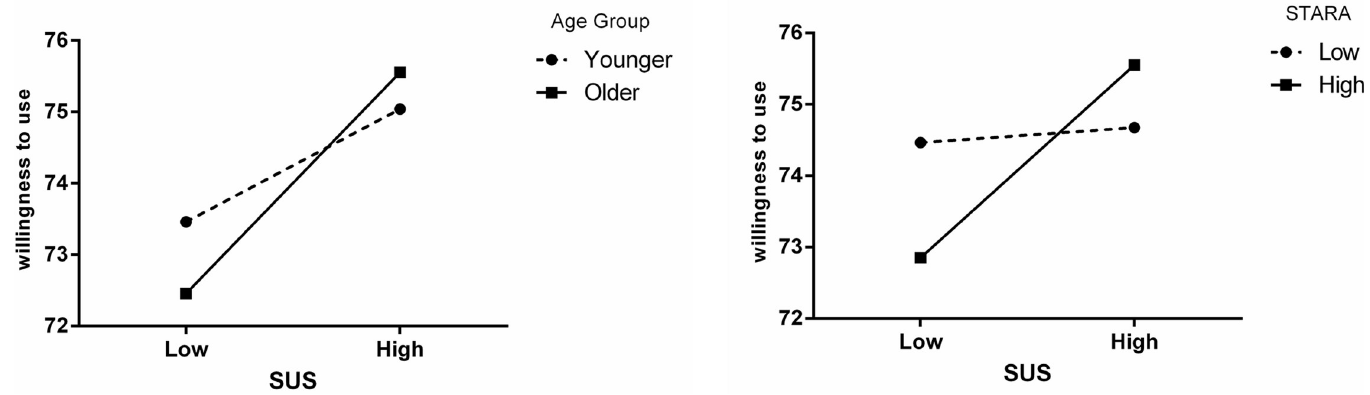
Fig 3. Moderating effect of age and STARA on the relationship between usability of a robot and willingness to use it.